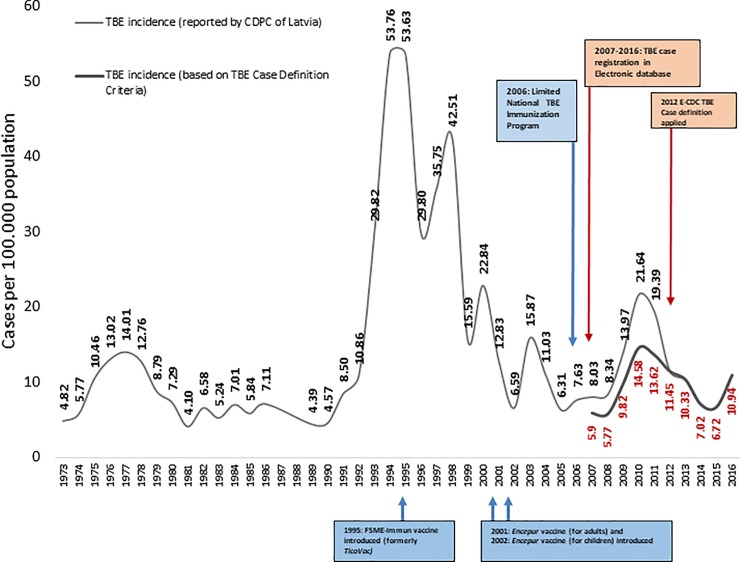
TBE incidence rates in whole population; 1973–2016; vaccine uptake gradually increased from 39% (2009) to 52% in 2015.